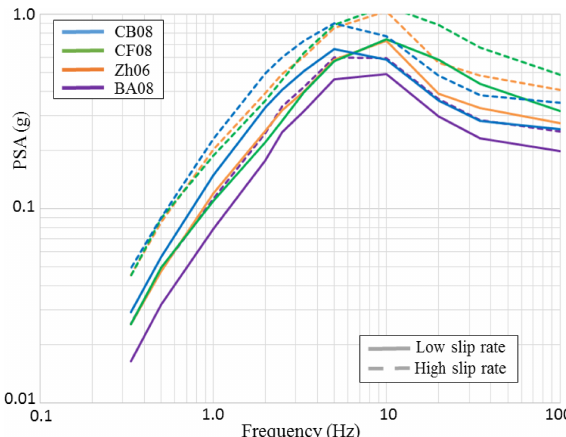
Figure 7. Comparison of UHS based on the Rhine River fault geo- dynamic model considering two slip rate values. Seismogenic depth of 15km, steepest dip of faults, a Gutenberg–Richter frequency- magnitude